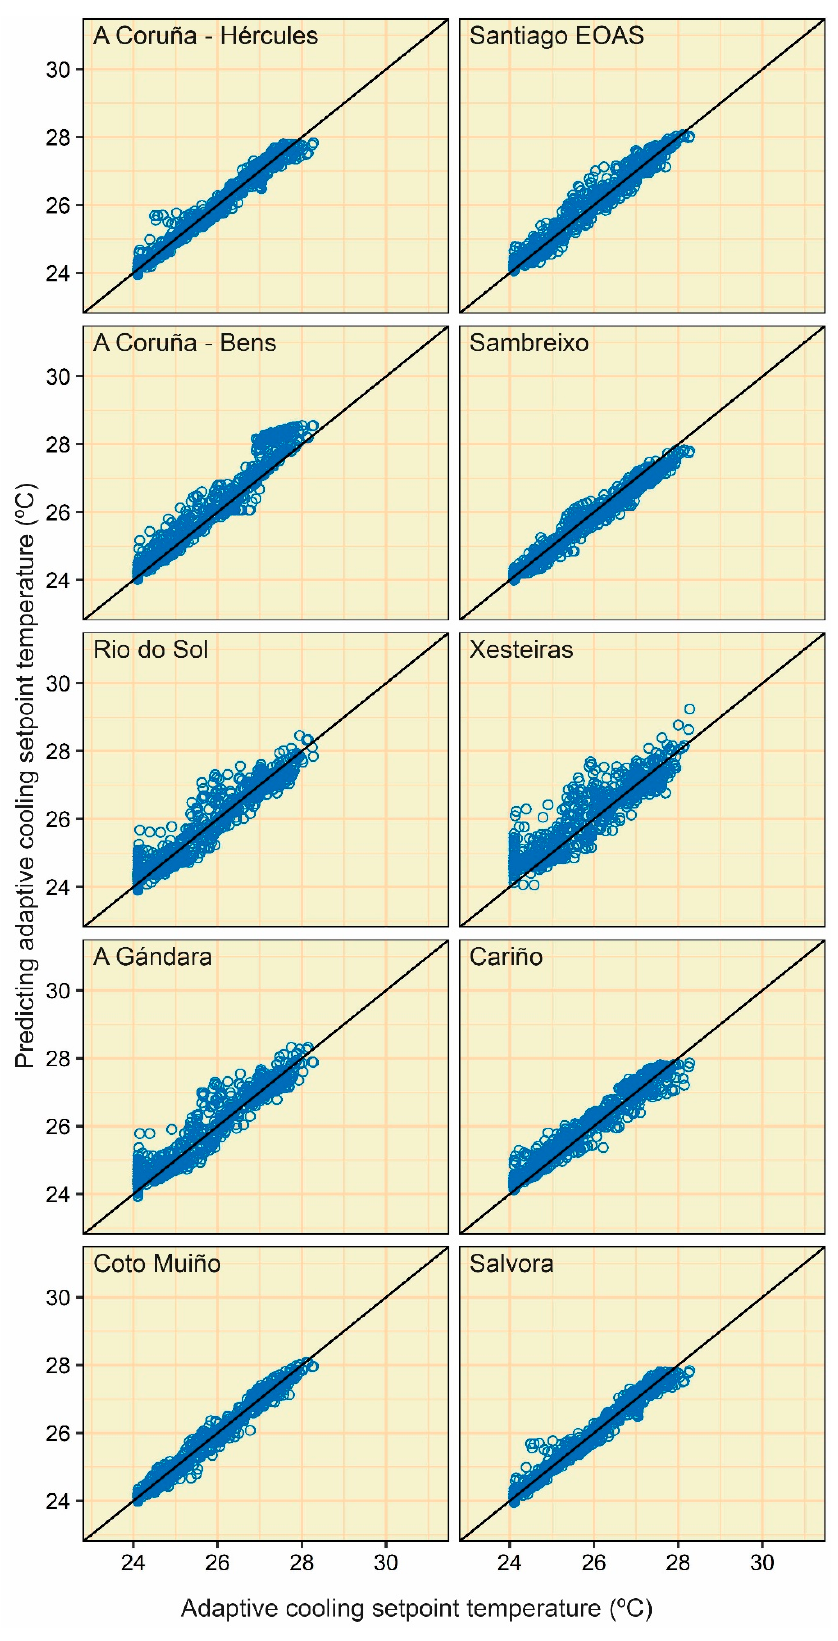
Figure A10. Point clouds between the actual and predicting adaptive cooling setpoint temperature values (category I) of the MLP (approach 2).